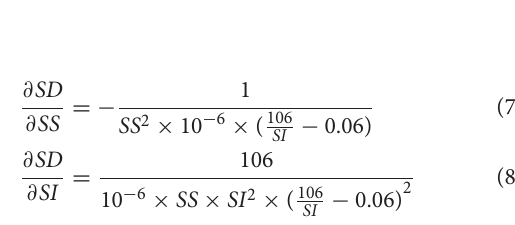
Frontiers in Plant Science |